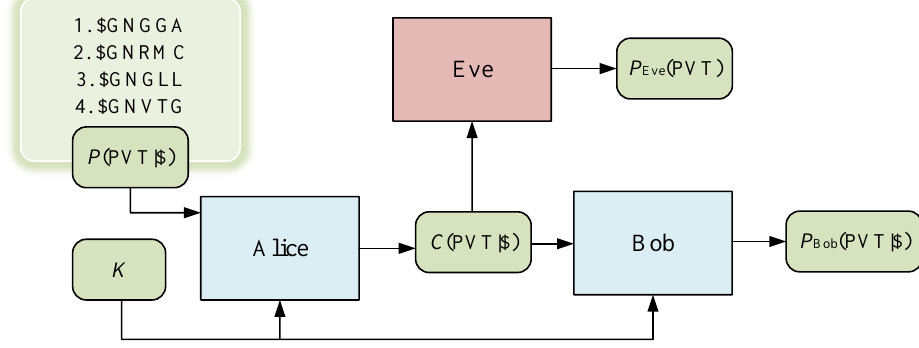
Figure 3. BeiDou PVT-information-encryption/decryption model based on a CGAN.